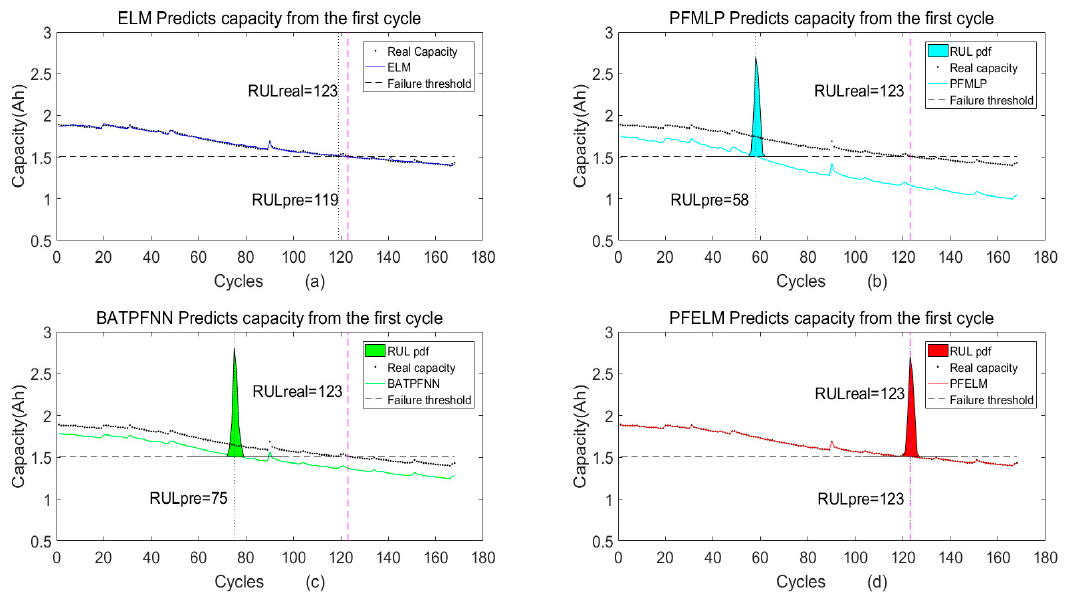
Figure 16. Predicting capacity from the first cycle by different algorithms: ( a ) ELM ; ( b ) PFMLP; ( c ) BATPFNN; ( d ) PFELM.